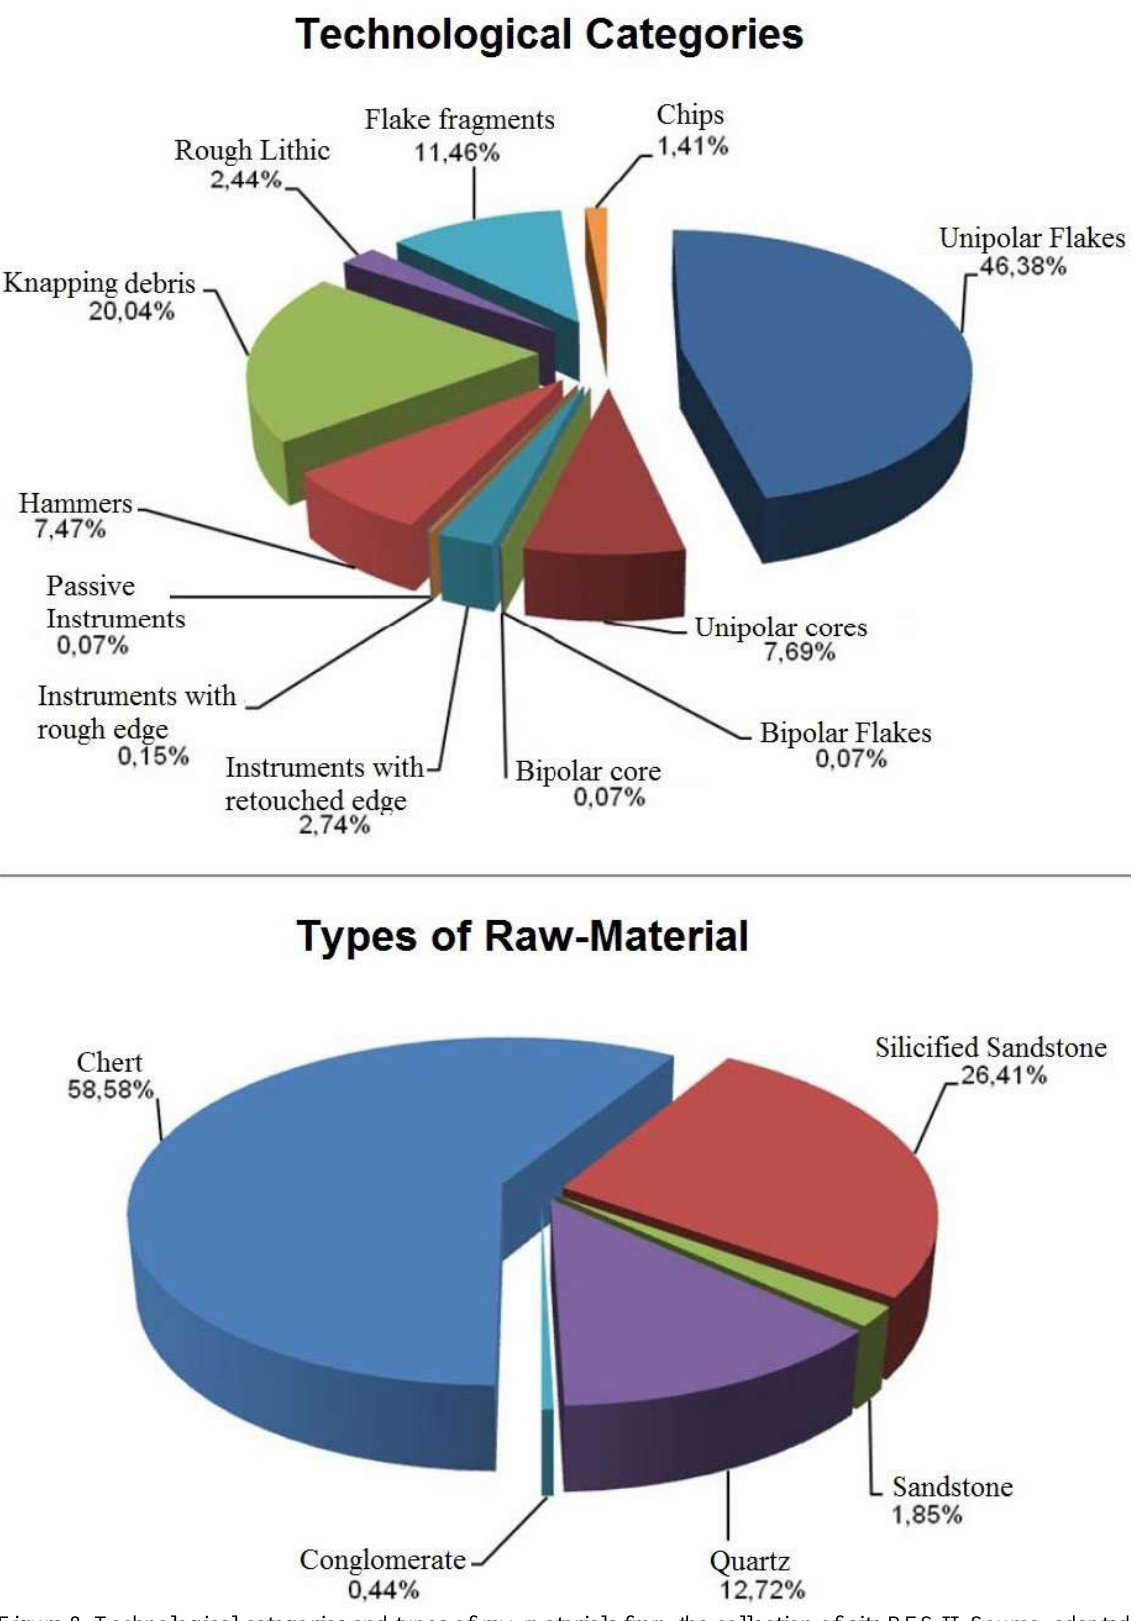
Figure 8. Technological categories and types of raw materials from the collection of site BES II. Source: adapted from Santos (2011) and Zanettini Arqueologia